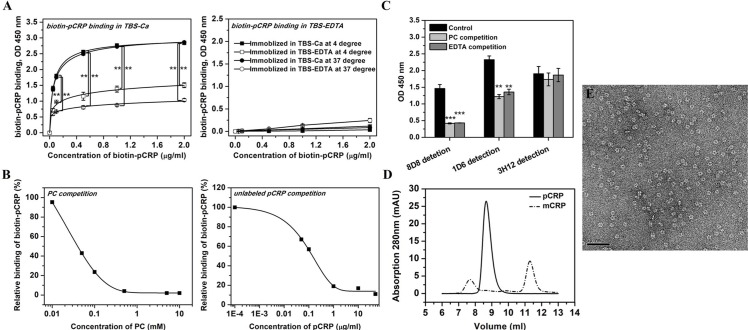
The intermediate formed on hydrophobic surfaces binds the solution-phase pCRP in a calcium-dependent manner with high affinity.(A) Binding of biotin-labeled pCRP to pCRP (5 μg/ml) immobilized in TBS-Ca (pH 7.4) overnight at 4°C. Biotin-labeled pCRP bound immobilized pCRP in a calcium-dependent fashion. **p < 0.01. This interaction affinity was much higher than the previously determined Kd for the homo-complex formation of pCRP (~1.5 nM vs. ~20 μM). (B) 5 μg/ml pCRP was immobilized in TBS-Ca (pH 7.4) overnight at 4°C. After incubation with PC (the left panel) or unlabeled pCRP (the right panel) at the indicated concentrations for 30 min, 0.2 μg/ml biotin-labeled pCRP was added for binding detection by HRP-avidin. The binding of biotin-labeled pCRP could be abrogated by PC and unlabeled pCRP. The results of one representative experiment were shown. (C) 5 μg/ml pCRP was immobilized in TBS-Ca (pH 7.4) overnight at 4°C followed by incubation with TBS-EDTA, 1% BSA or 2 mM PC in TBS-Ca (pH 7.4), 1% BSA for 1 h. The PC or EDTA treatments both significantly eliminated the post-binding of the solution-phase pCRP (**p < 0.01, ***p < 0.001 against control). However, the immobilized antigen still showed significant dual antigenicity as detected by 8D8, 1D6 and 3H12 mAbs. (D) Homogeneity analyzed by size-exclusion chromatography of pCRP and mCRP in solution phase. 120 μl of pCRP or mCRP at concentration of 0.1 mg/ml were injected and eluted from a Superdex 75 column attached to an AKTA purifier at a flow rate of 0.75 ml/min, respectively, and absorption values at 280nm were recorded. pCRP showed no heterogeneity while mCRP exhibited a certain amount of aggregations (E) Visualization of pCRP in TBS by electron-microscopy(EM). Scale bar = 50 nm. No apparent self-association of CRP like decamer was observed. Data were obtained from at least three independent experiments and represented as mean ± SEM unless otherwise stated. For A and B, values underwent a nonlinear curve fit with OriginPro 8 software, during which the category was set as “Growth/Sigmoidal” and the function was set as “Hill1”.